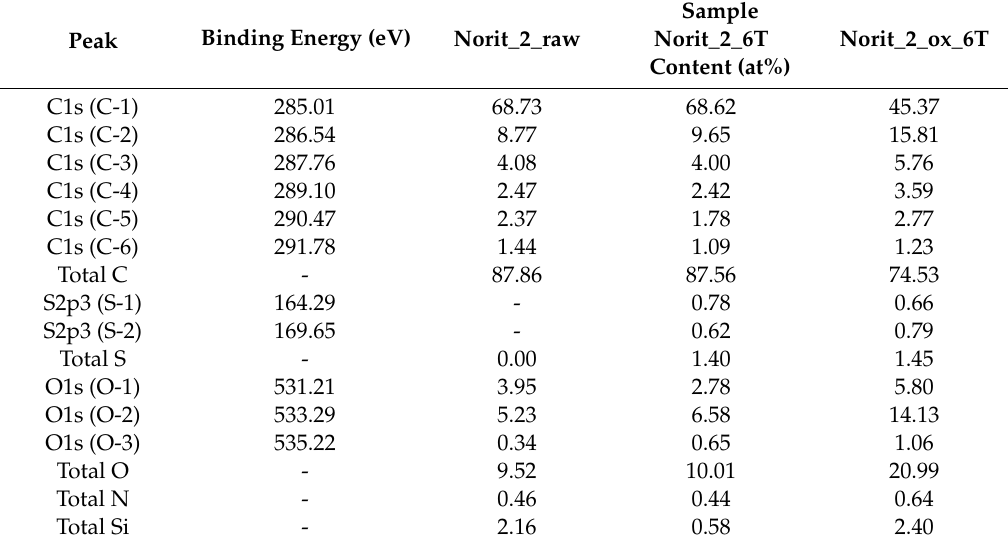
Table 2. Results of the XPS spectra elaboration in C1s, O1, S2p3 region and total content of N and Si of the